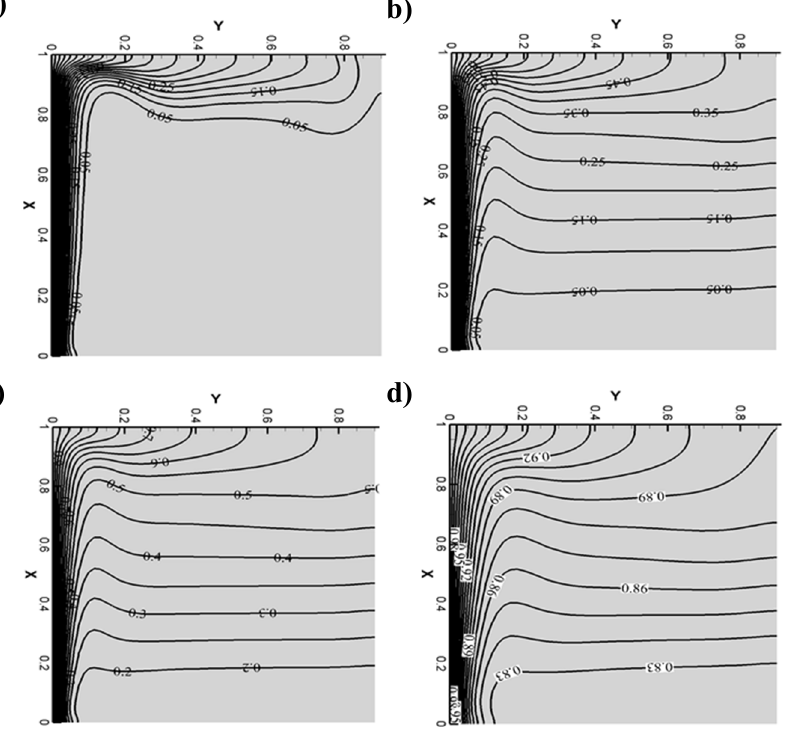
Figure 4. Isotherms for Ra = 10 6 and R in = 0.1, at different time frames .